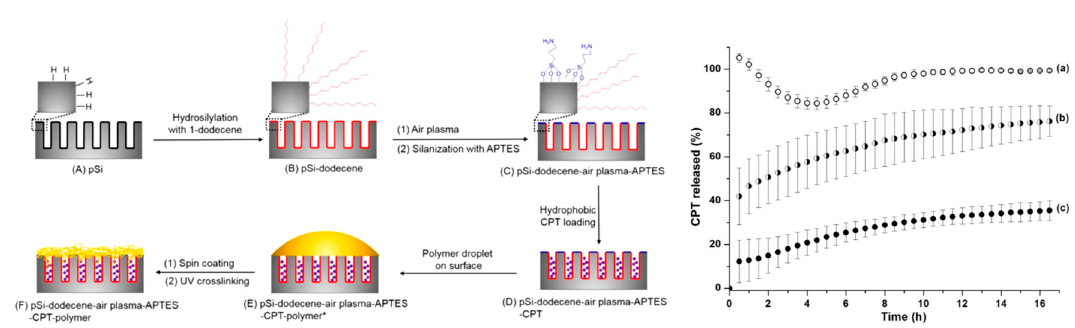
Figure 6. Schematic diagram showing the di ff erential functionalisation of interior and exterior surfaces of pSi films to allow improved camptothecin (CPT) drug loading and release and CPT release profiles from ( a ) pSi-ozone-APTES, ( b ) pSi-dodecene-air plasma-APTES, and ( c ) pSi-dodecene-air plasma-APTES-2 wt% poly(HPAm-co-BPAm). Reproduced with permission from [114].